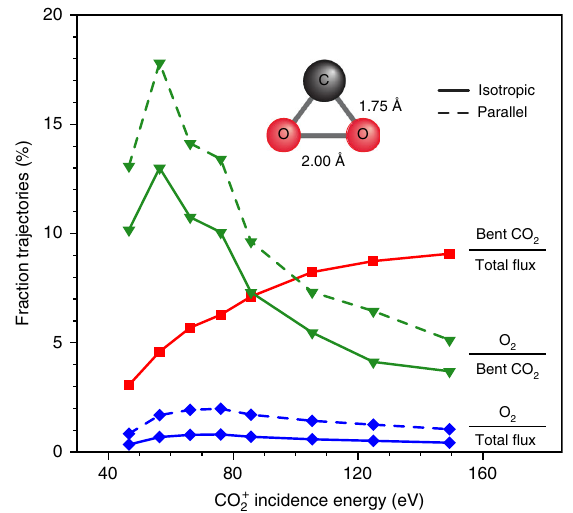
Fig. 4 Reaction probabilities for symmetric dissociation of CO 2 on Au. Calculated total O 2 yields for isotropic (solid blue line) and parallel (dashed blue line) orientation of incident CO 2 as a function of incidence